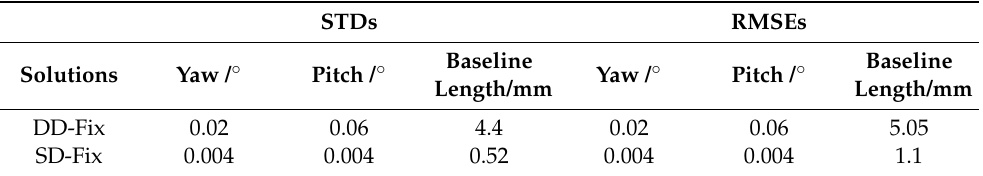
Figure 5. Line graph of attitude and baseline length by DD-Fix and SD-Fix solutions. Table 2. Standard deviations (STDs) and root mean squared errors (RMSEs) of yaw, pitch angles, and baseline between DD-Fix and SD-Fix .